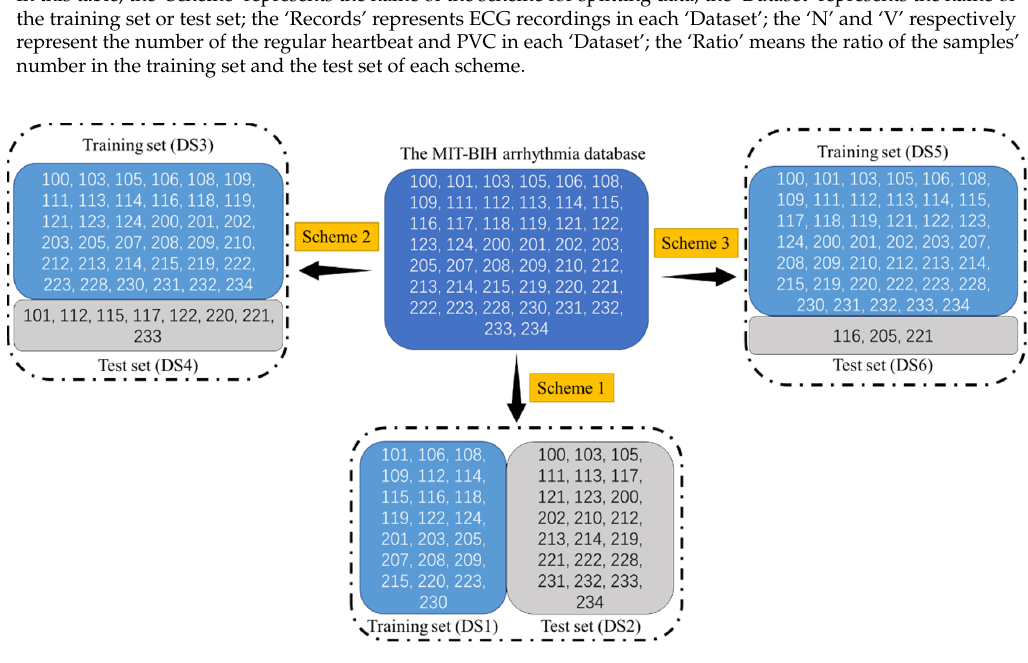
Table 2. Splitting data into training and test